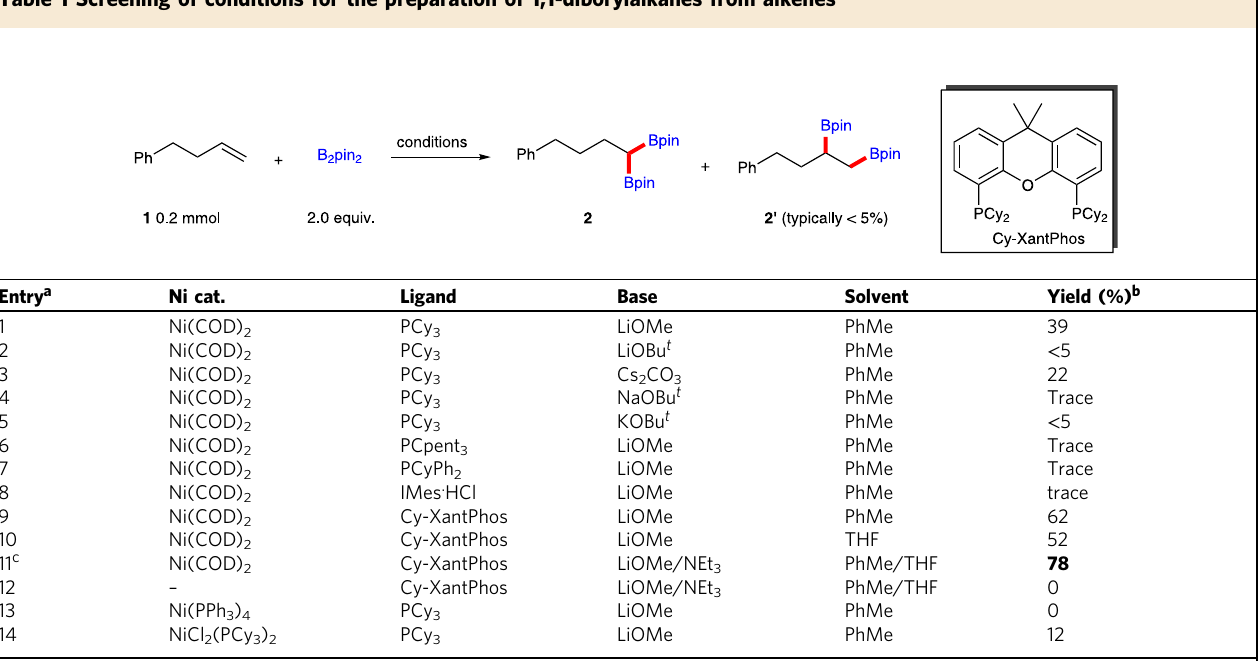
Table 1 Screening of conditions for the preparation of 1,1-diborylalkanes from